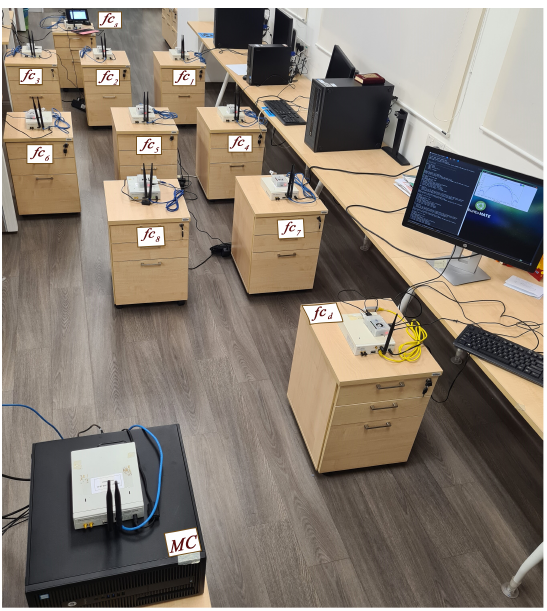
Figure 5. Experimental setup for the hybrid route selection with three D2D routes and a backbone route via MC BS. Algorithm 2 RL mechanism at distributed nodes and